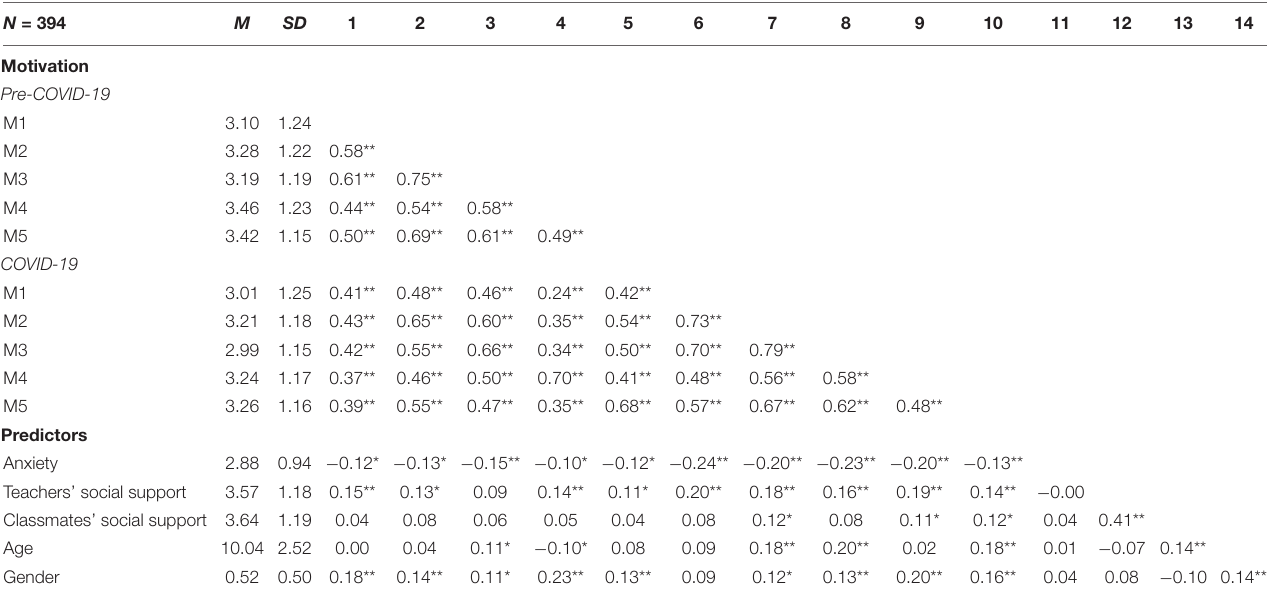
TABLE 2 | Correlation matrix with Means ( M ) and Standard Deviations ( SD ).